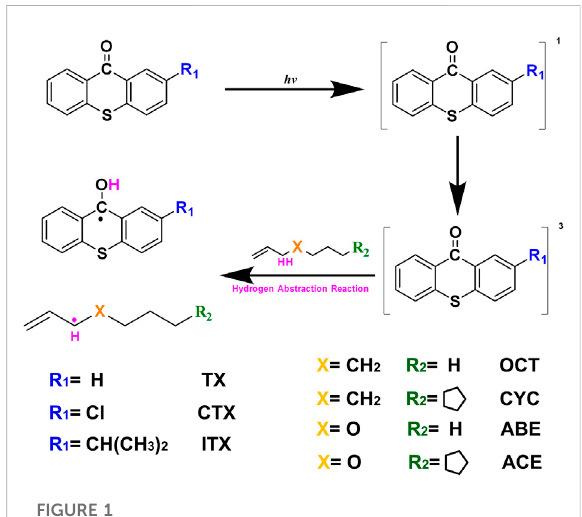
FIGURE 1 Mechanism of excited TXs as hydrogen acceptors reacting with C-H